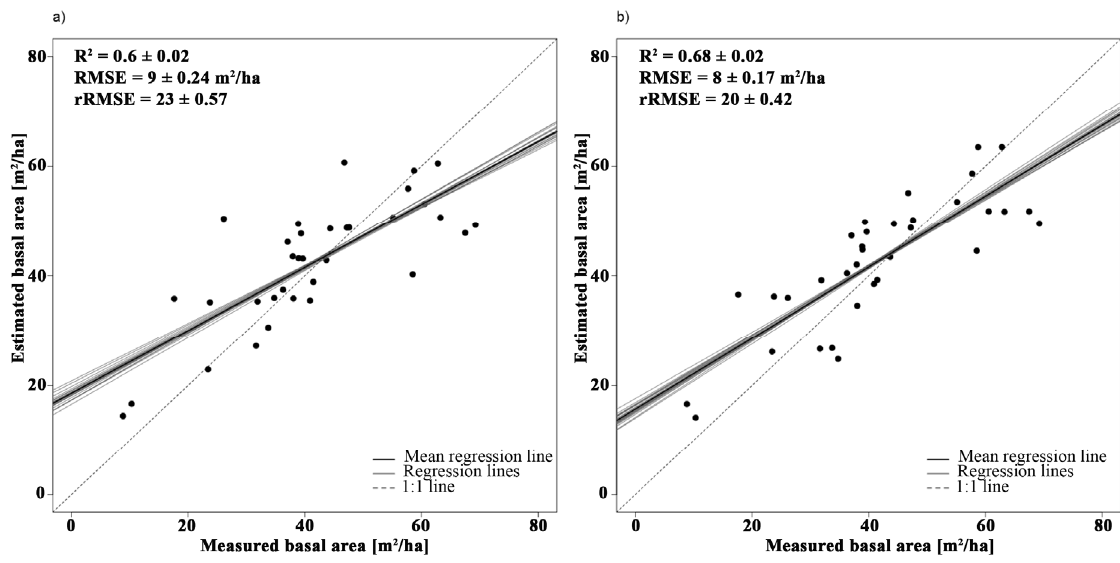
Figure 5. Agreement of estimated basal area with in-situ data; ( a ) simple regression model based on an SR index; ( b ) stepwise multiple regression model based on a band depth index and an SR type index. The corresponding wavelengths of the indices are given in Table 4. Coefficient of determination (R 2 ± SD), root mean square error (RMSE ± SD), and relative root mean square error of prediction (rRMSE ± SD) are shown.